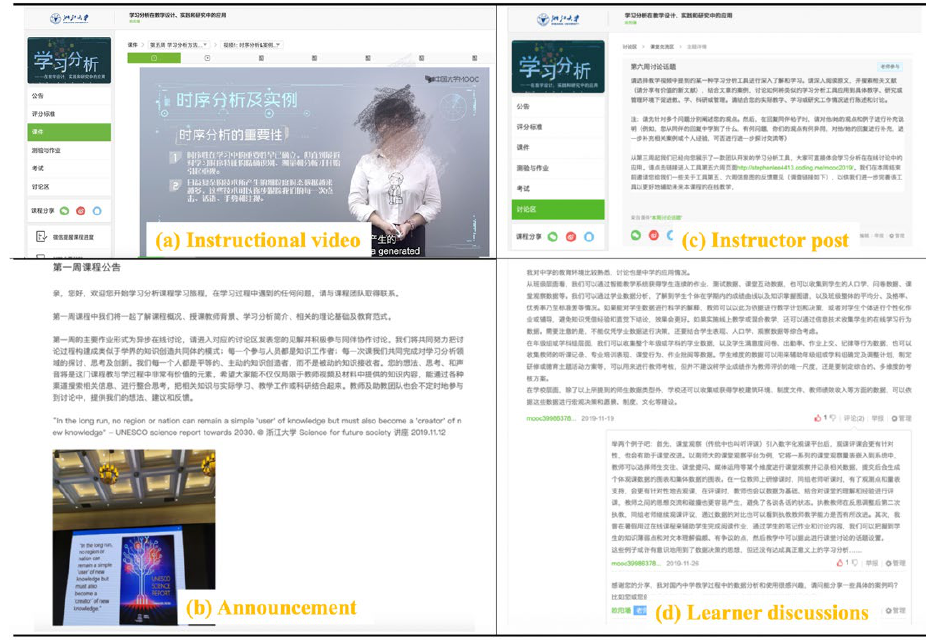
Figure 1 . The MOOC